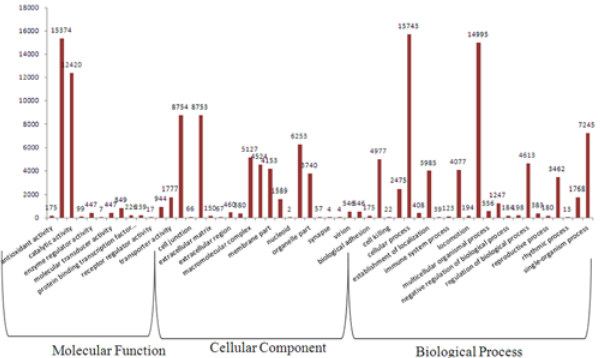
Fig 1. Functional classification of assembled unigenes. Functional classification of assembled unigenes based on Gene Ontology (GO) categorisation. The results are summarised in three main GO categories: biological process, cellular component and molecular function. The x-axis indicates the subcategories, and the y-axis indicates the numbers related to the total number of GO terms present; the unigene numbers that are assigned the same GO terms are indicated on the top of the bars.